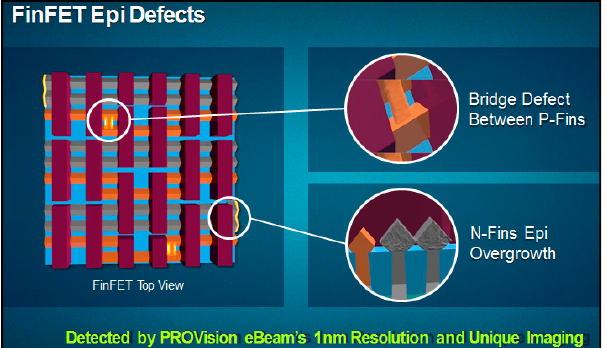
Figure 1. Bridge defect and Epi overgrowth detected by e-beam image. Challenges faced for Fin field-effect transistor Electron Beam Inspection (EPI) undetected defects can be detected by e-beam